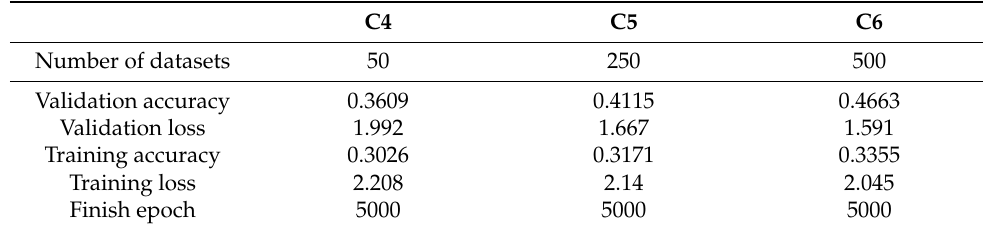
Table 3. Number of datasets results.